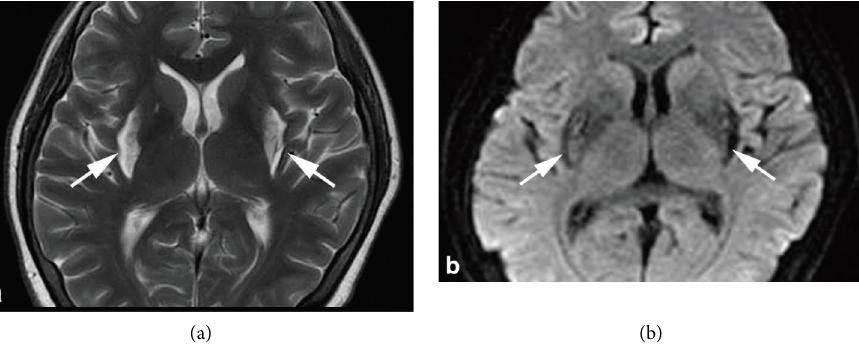
Figure 3: MRI identifed putaminal lesions in patients with methanol-induced optic neuropathy. Brain MRI images of patient 7, 116 days after acute onset of methanol poisoning, (a) axial T2 image demonstrating hyperintense signals (arrows) in bilateral putamina, and (b) DWI b � 1000 image demonstrating dominant low signal and partial high signal in the putaminal lesion.